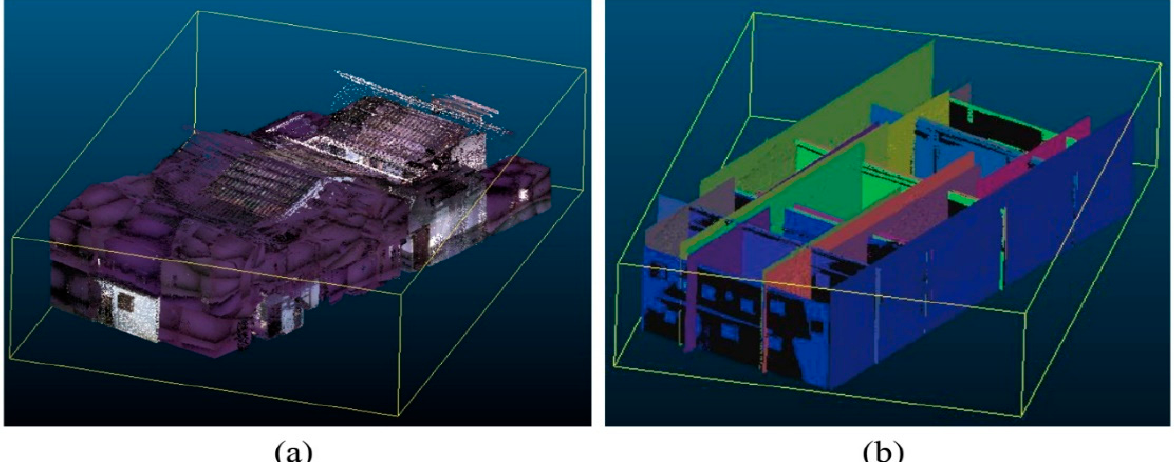
Figure 4. Planar features segmented from the original point cloud using the RANSAC plane fitting algorithm: ( a ) original point cloud of a historical building; ( b ) the segmented planar features.